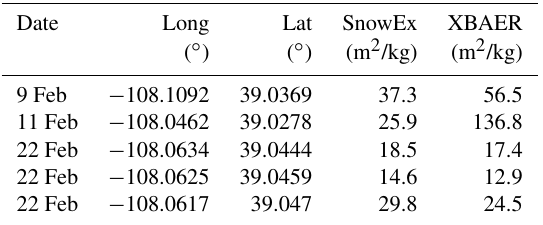
Table 6. The comparison between SnowEx SSA and XBAER- retrieved SSA during February